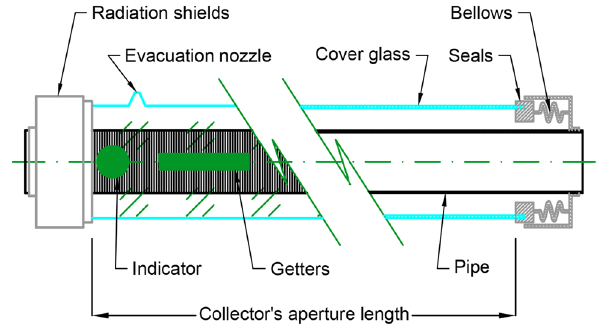
Figure 6: Receiver for heating applications.